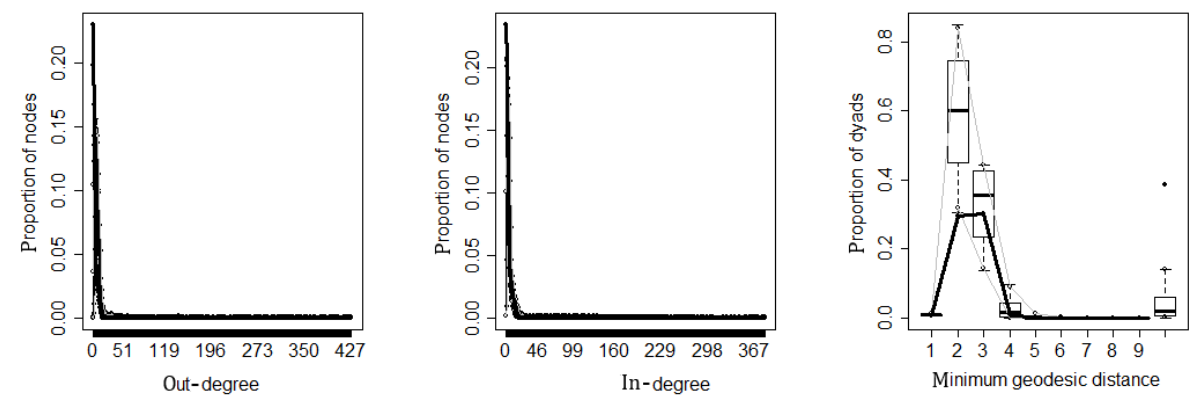
Figure 5. Goodness of fit for measures from simulated emotional support